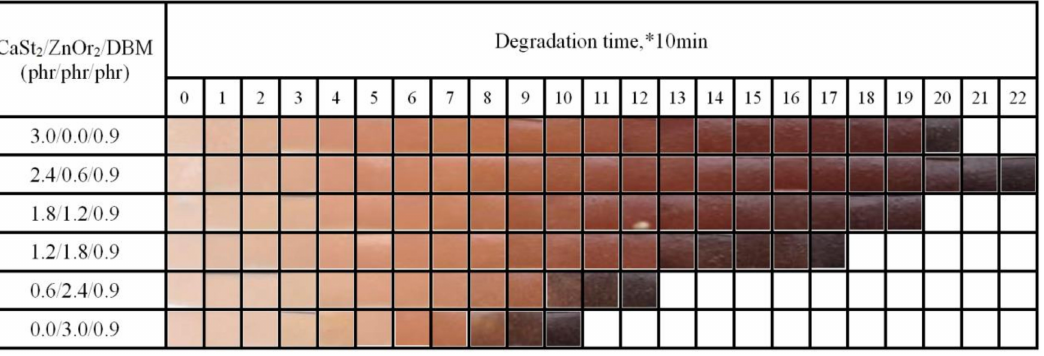
Figure 12. The effects of thermal stability time for PVC with different proportions of CaSt 2 /ZnOr 2 /DBM thermal stabilizers at 180 ◦ C.